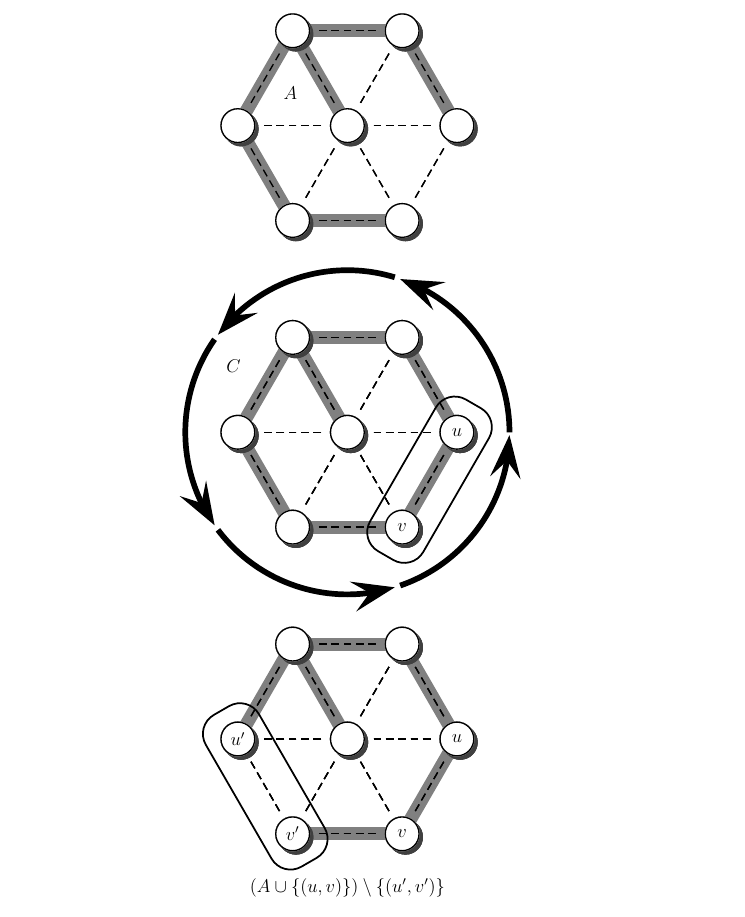
Figure 3. Edge-swap procedure. Inserting the edge ( u , v ) into the initial tree A generates a cycle C . Figure 3: Edge swap procedure, in- The edge ( u (cid:48) , v (cid:48) ) is removed from C serting the edge ( u,v ) into the ini- tial tree A generates a cycle C . The edge ( u ′ ,v ′ ) is removed from C .